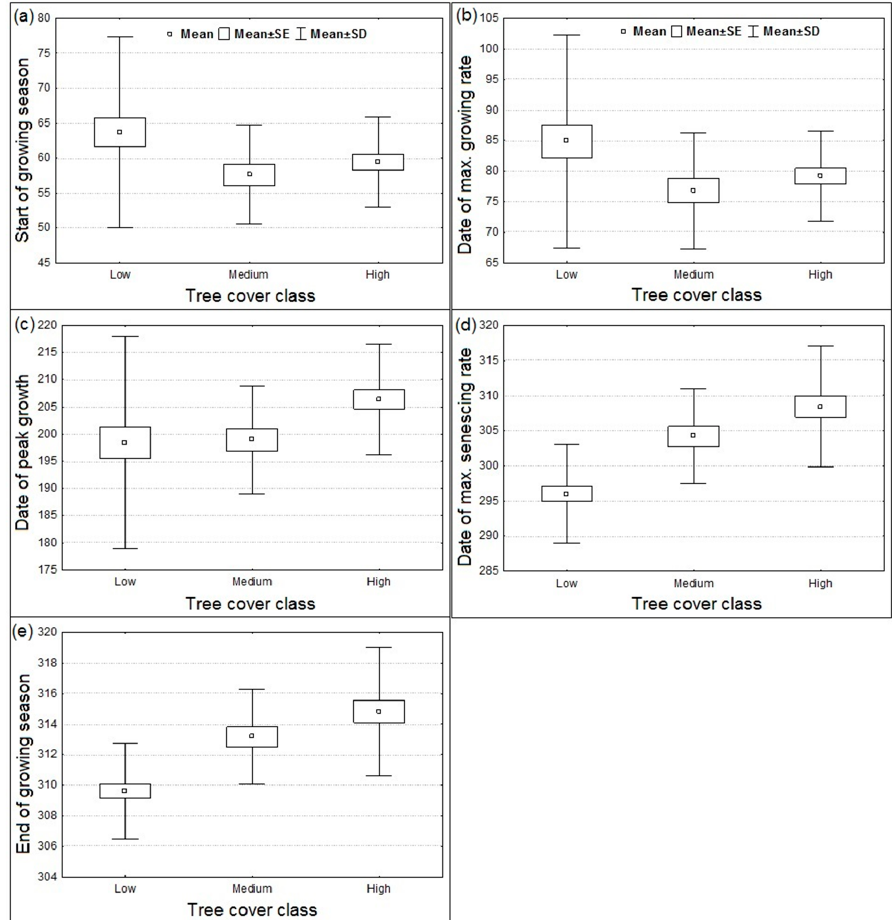
Figure 7. Differences in land surface phenology between three tree cover (%) classes (low, medium and high) for day of the year at: ( a ) start of growing season; ( b ) maximum growing rate; ( c ) peak growth; ( d ) maximum senescing rate; and ( e ) end of growing season. The Austral used in the study ranges from 4 July (Julian Day 185) of one year to 26 June (Day 177) of the following year. Table 3. Differences in the means and variances between tree cover (%) classes using t and f tests. Phenological Metrics t-Value for Differences in Means p for Differences in Means F-Ratio for Differences in Variances p for Differences